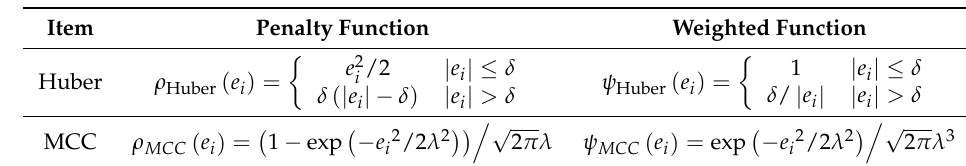
Table 2. The weighted functions of two methods.